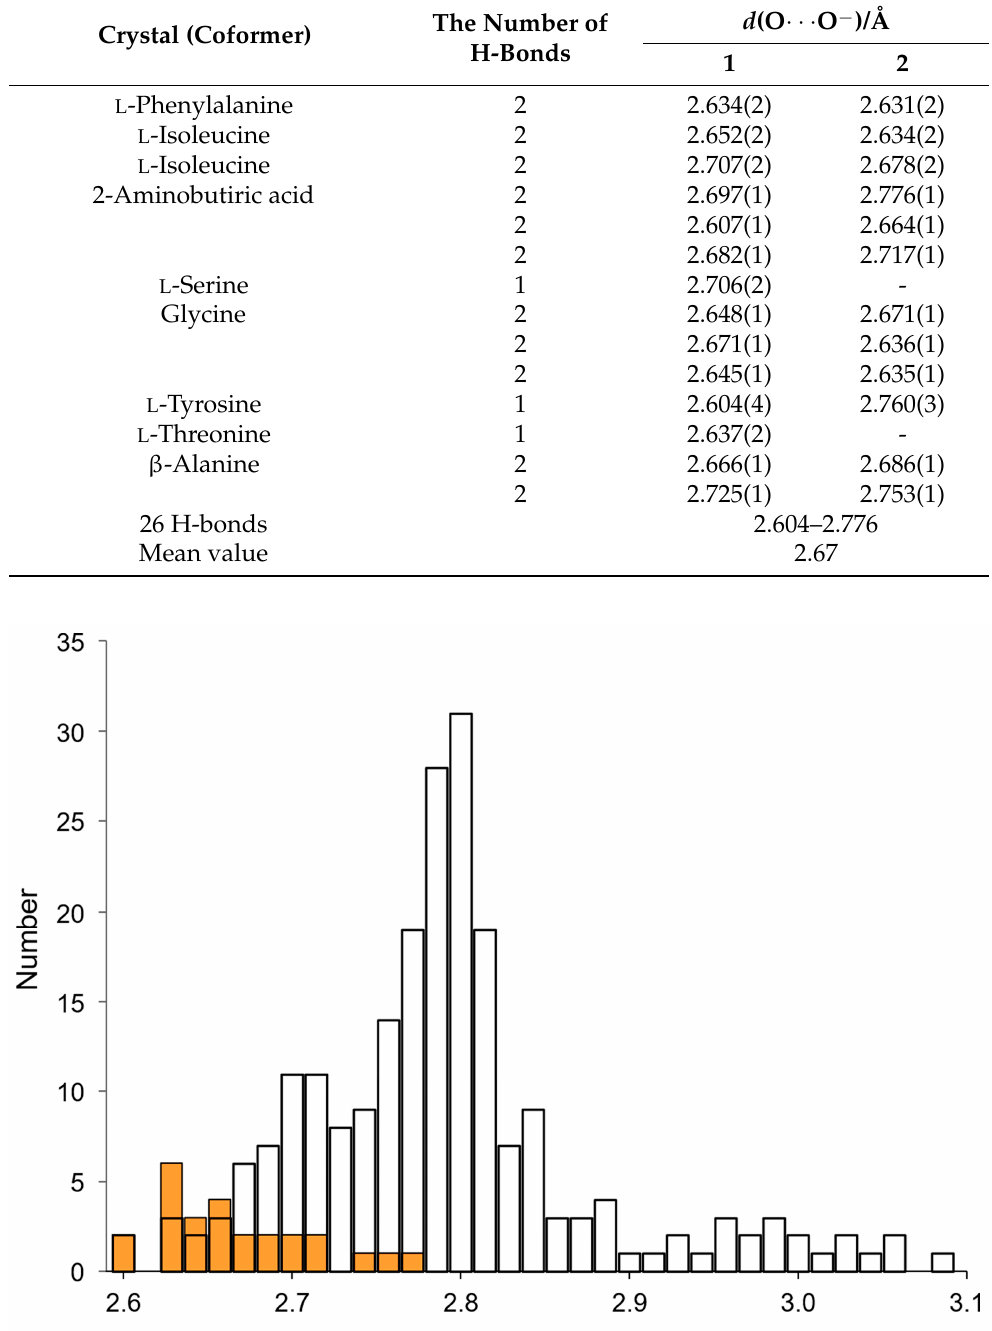
Table 1. H-bonds of H 2 O 2 molecules as proton donors in crystalline peroxosolvates of amino acids and non-proteinogenic amino acids [95]: the number of H-bonds formed by one H 2 O 2 molecule and O ··· O − distances d (O ··· O − ).